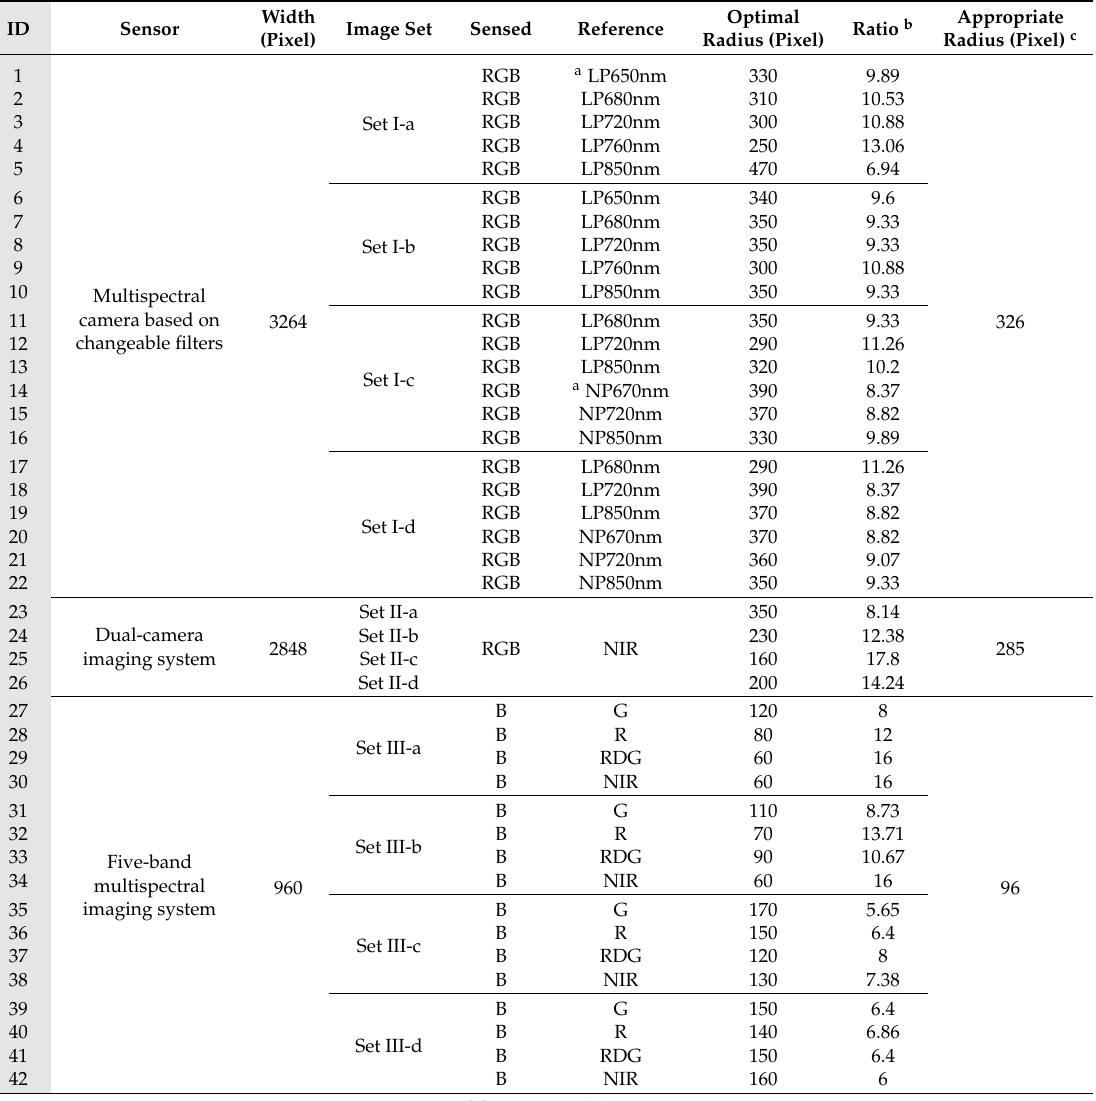
Table 2. Appropriate radius size based on the image width. RGB—red, green, and blue; NIR—near- infrared;